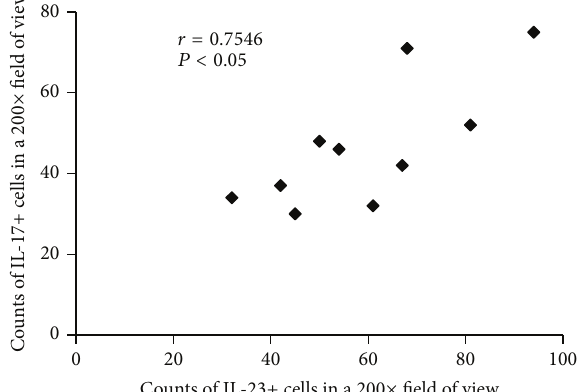
Figure 4: Correlation between IL-23+ cells and IL-17+ cells in the lesions of PV. The counts of IL-23+ cells and IL-17+ cells were the average number of three 200x fields of views from three sections. Significance of the correlation was assessed by Pearson